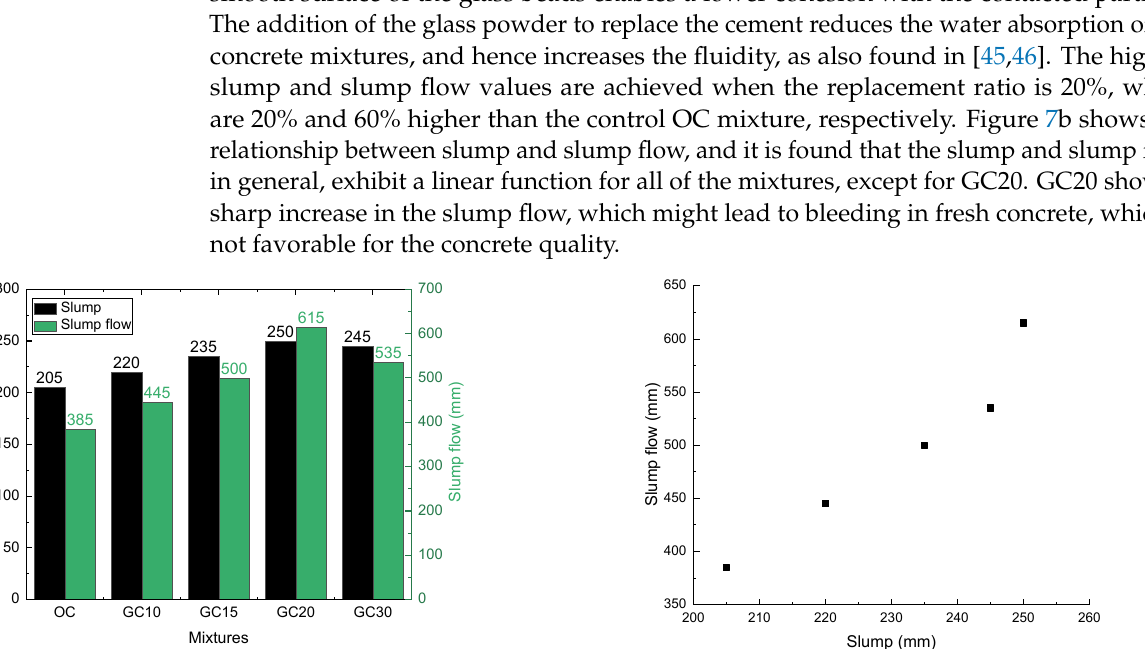
( b ) Figure 6. CFST testing under compressive loading: ( a ) experimental setup; ( b ) strain gauges (enlarged). 3. Test Results and Discussion 3.1. Material Properties